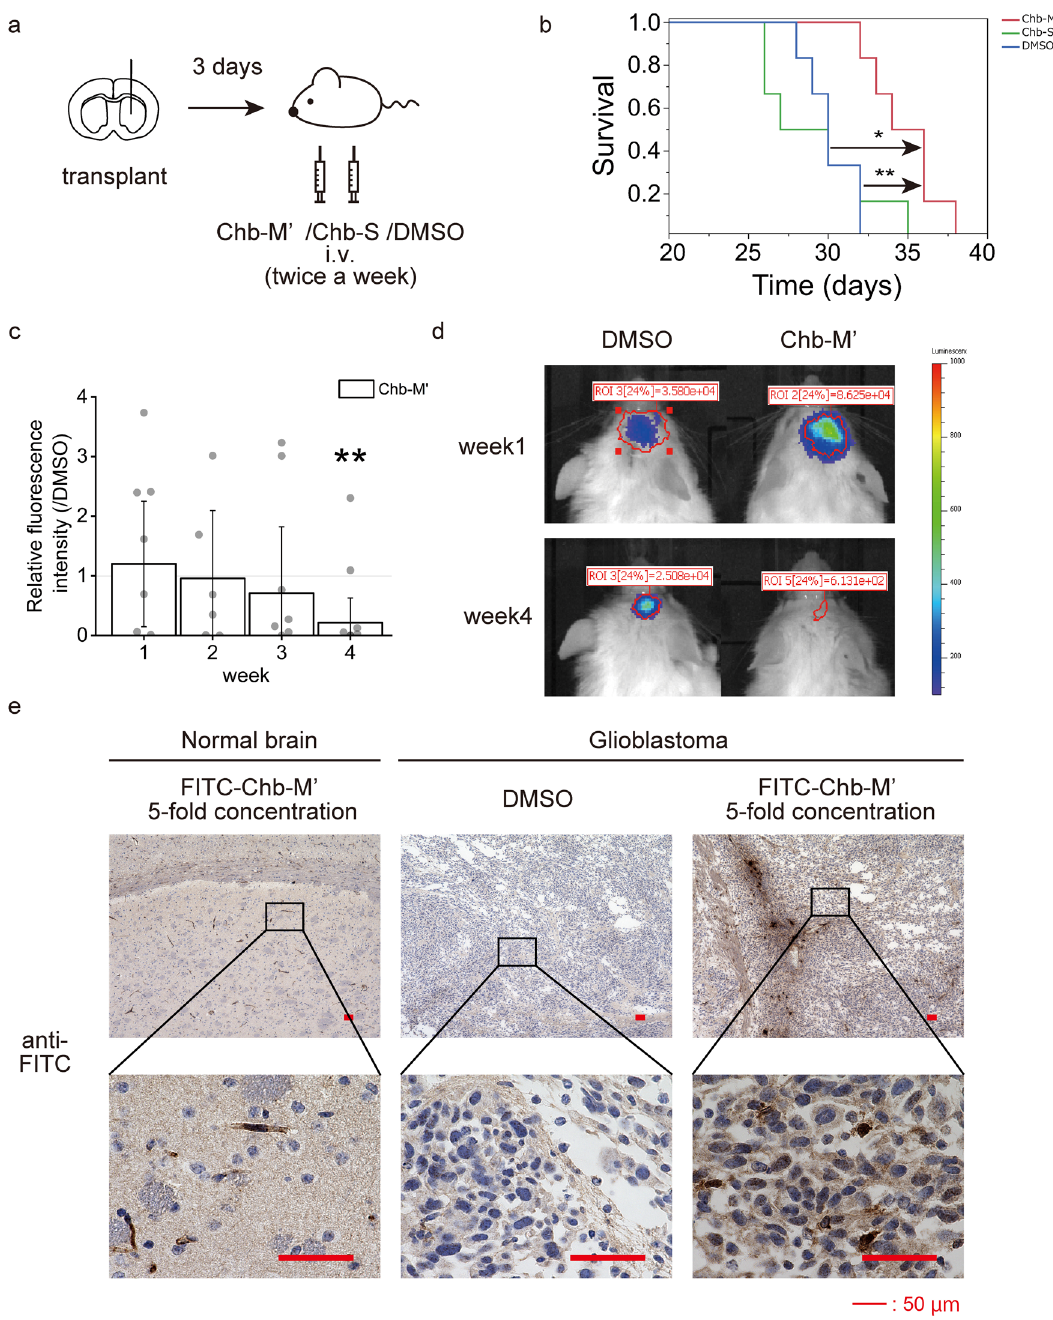
Fig. 4 Chb-M' penetrates the blood – brain barrier and improves survival in mice with glioblastoma. a Schematic representation of treatment schedule in xenotransplanted mice. b Overall survival of BALB/cSlc-nu/nu mice transplanted with LN229 followed by treatment with Chb-M' or Chb-S or DMSO. n = 6. p < 0.05, by log-rank test (Bonferroni correction). c Relative fl uorescence intensity of NOG mice transplanted with PDM379 treated by Chb-M ’ . n = 6. Data represent mean ± 95% CI. * p < 0.05, by Welch ’ s t -test. d Representative luciferase imaging of NOG mice transplanted with PDM379 treated by Chb- M ’ and DMSO. e Pathological samples of normal brain and intracranial tumour treated with FITC-labelled Chb-M' and DMSO immunostained with goat anti-FITC antibody. Scale bars: 50 μ